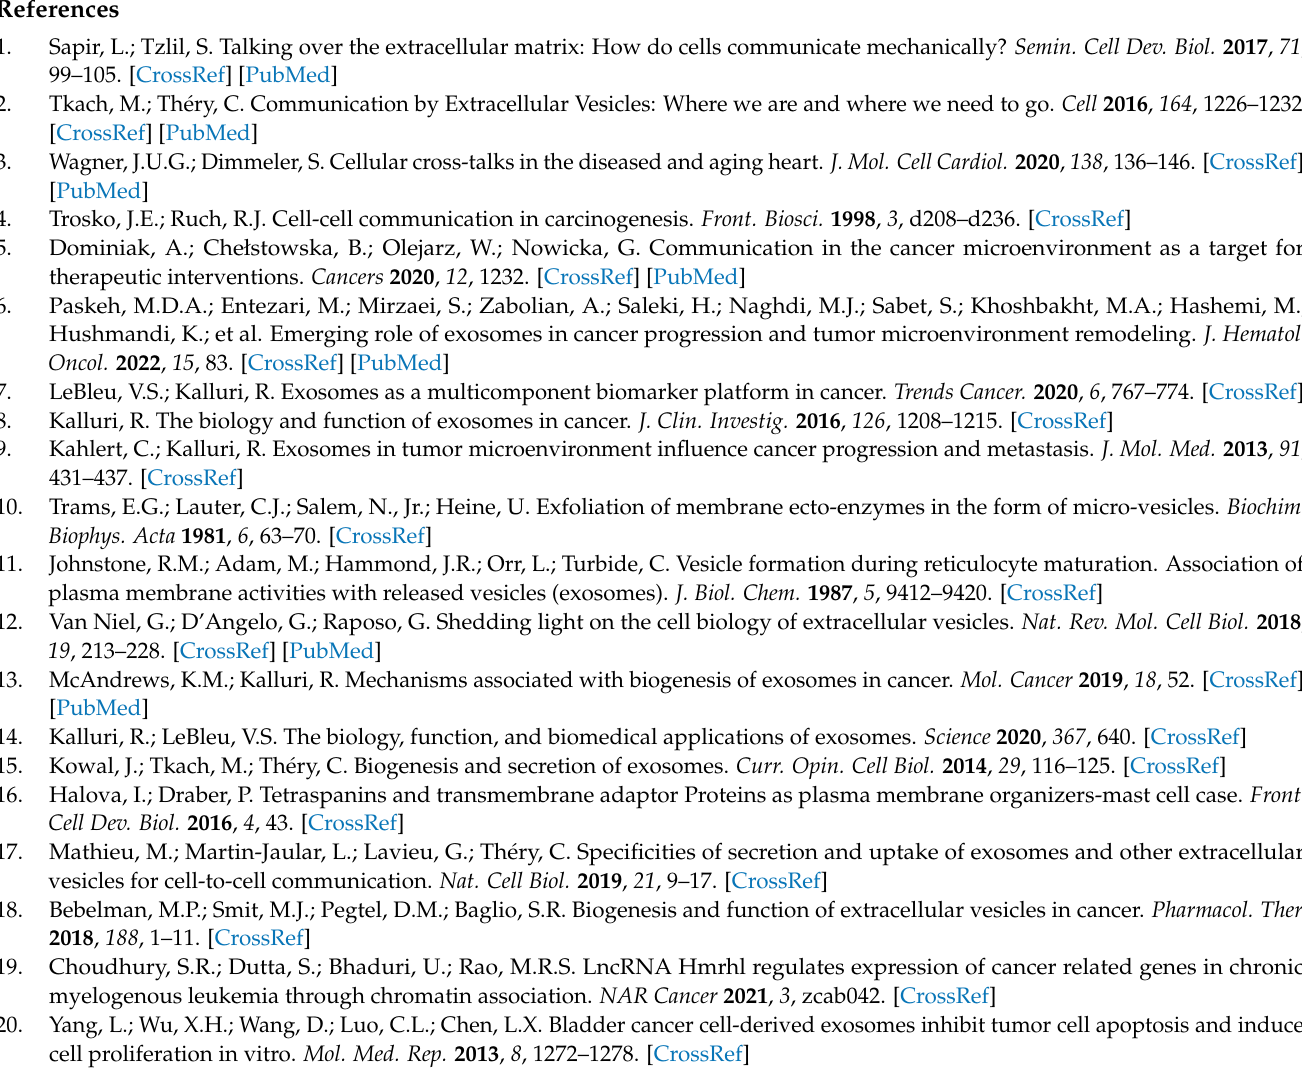
cells; Figure S3: Effects of exosome release by mTORC1 inhibition in TSC1-null cells; Figure S4: Effects of exosome release by mTORC1 inhibition in TSC1- or TSC2-silencing cells; Figure S5: Effects of exosome release by mTORC1 inhibition in HEK293 cell transfected with scrambled siRNA; All raw data from western blotting are in Supplementary Figure S6 of the Supplementary